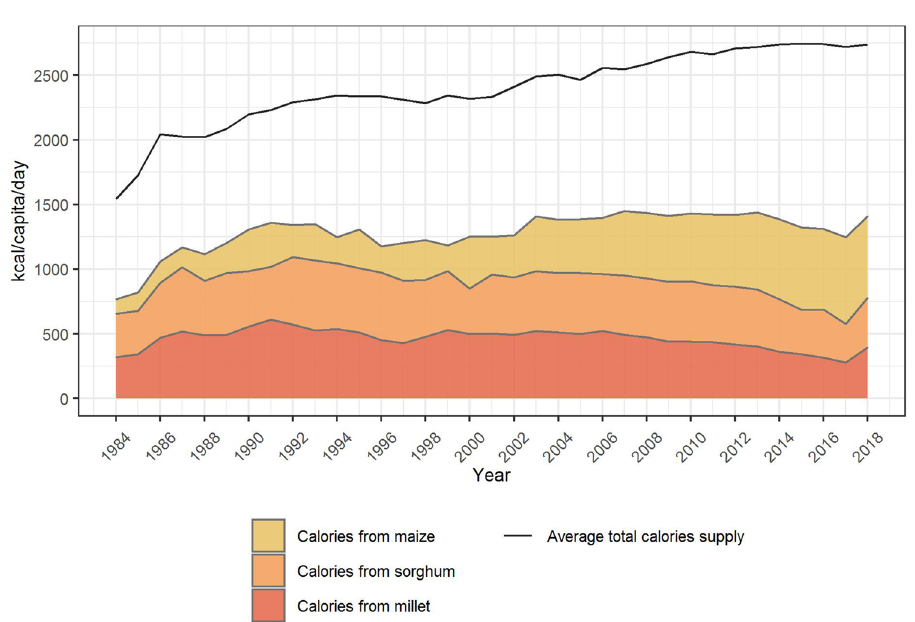
Figure 6. Supplied calories from maize, sorghum and millet and total supplied calories per capita and day in Burkina Faso from 1984 to 2018 in Burkina Faso. The calories supply refers to the total amount of